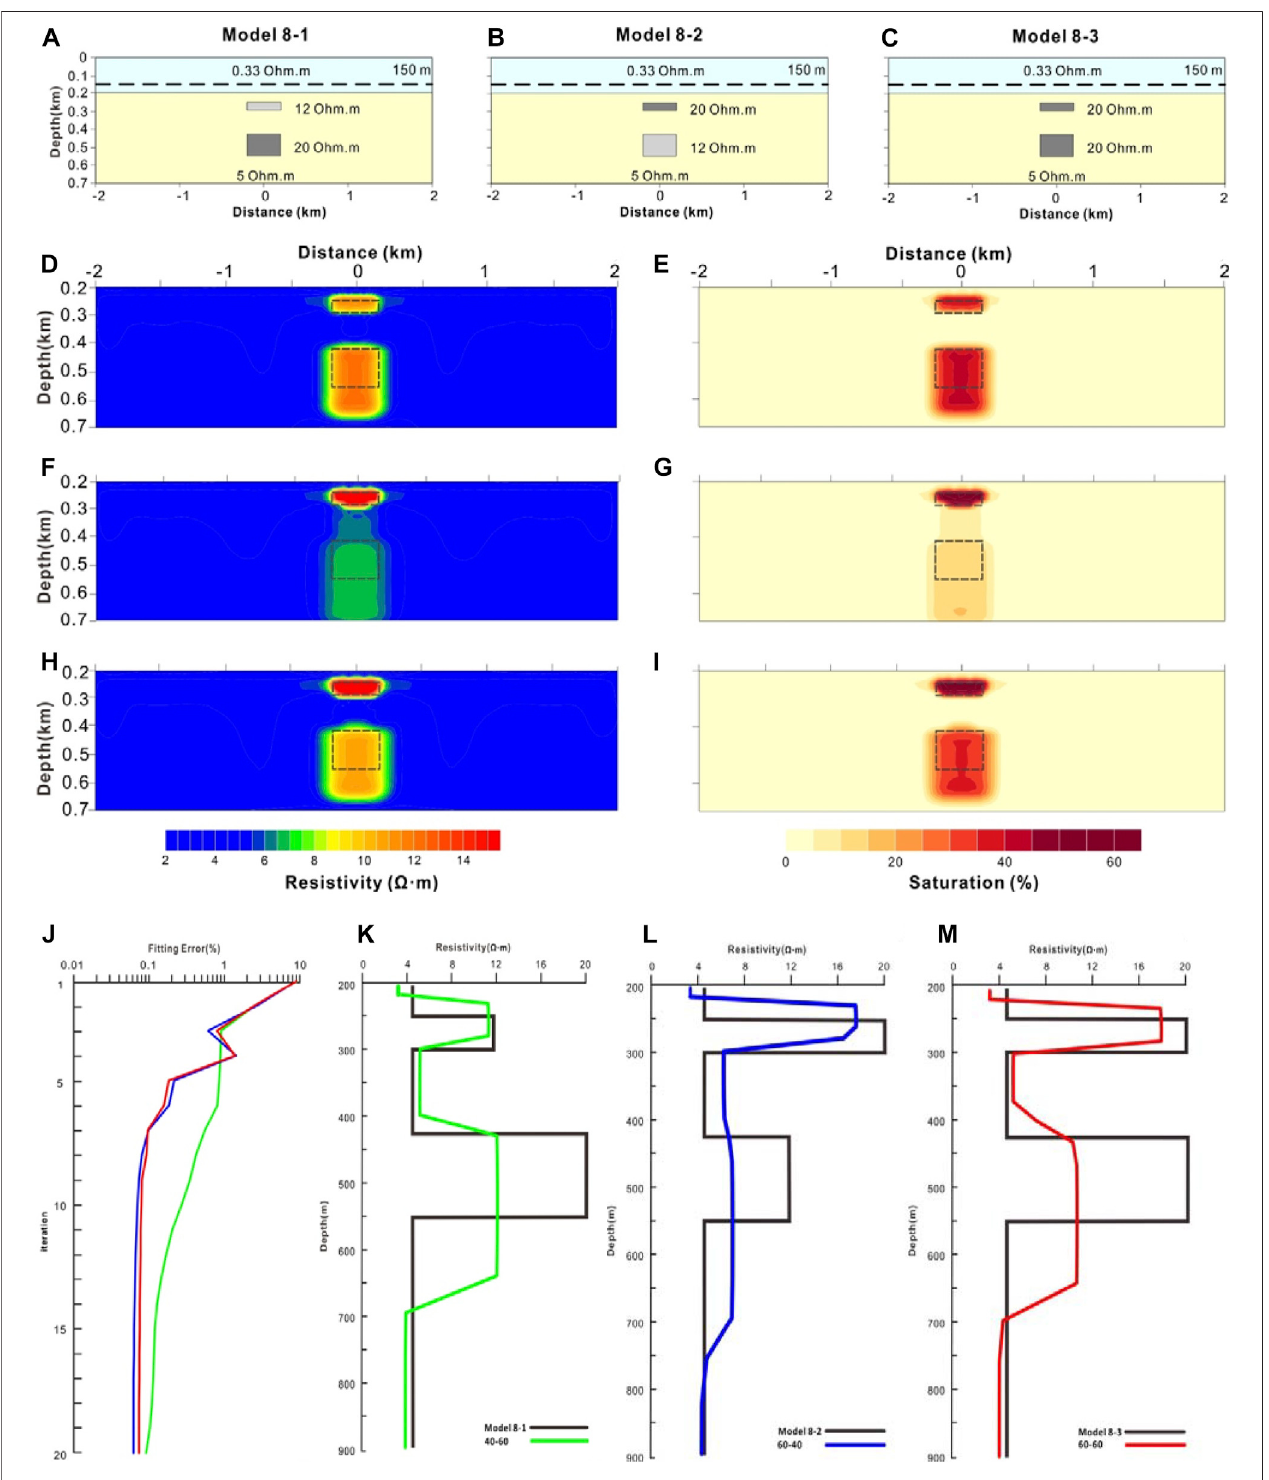
FIGURE 11 | Resistivity inversion and hydrate saturation estimation of various vertical distribution combination models of hydrate reservoir. (A) – (C) : the schematic diagram of Model 8 – 1, 8-2, and 8-3 respectively, light blue indicates seawater, light yellow indicates marine sediments, gray block indicates hydrate reservoirs, dotted lineindicates thetrack ofthe towedDCR arrayarrangement; (D) , (F) and (H) :theinversion resistivityofModel 8 – 1, 8-2,and 8-3respectively; (E) , (G) and (I) :the hydrate saturation estimation of Model 8 – 1, 8-2, and 8-3 respectively (J) : the inversion iteration convergence of Model 8 – 1(green), 8 – 2(blue) and 8 – 3 (red) respectively (K) – (M) : the resistivity pro fi le with depth at the center x position of hydrate reservoir of Model 8 – 1(green), 8 – 2(blue) and 8 – 3 (red), respectively.